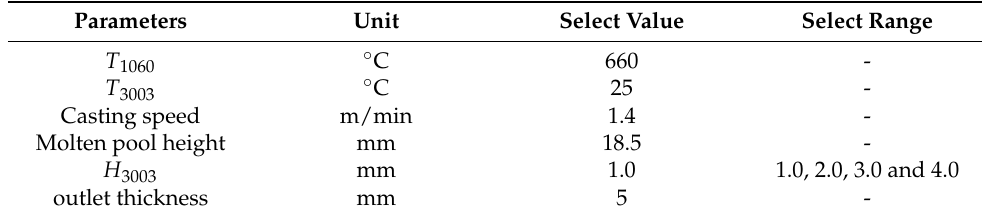
Table 5. Process Parameters of